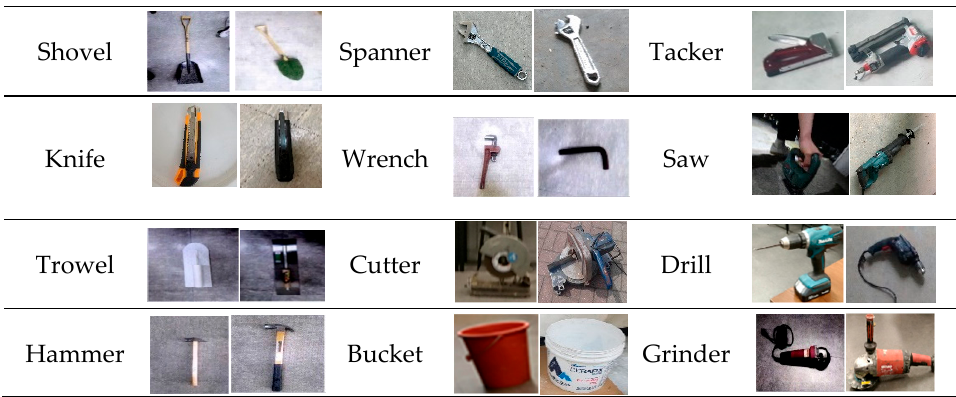
Figure 7. Simulation utilities for experimental data, ( a ) simulated indoor construction environment, ( b ) device used for 3D point cloud mapping.